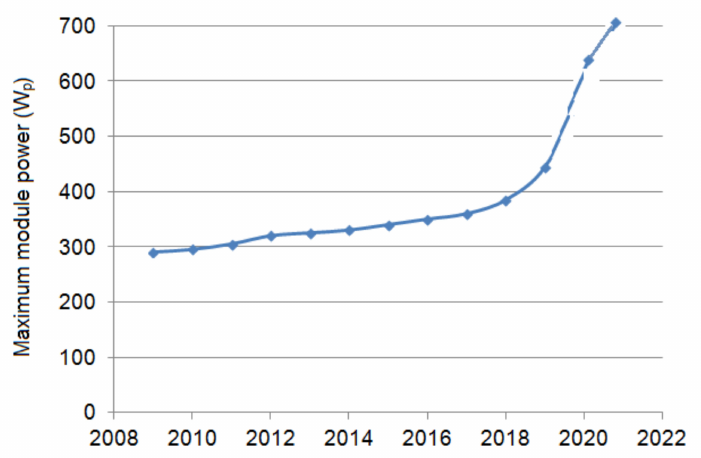
Figure 15. Maximum module power